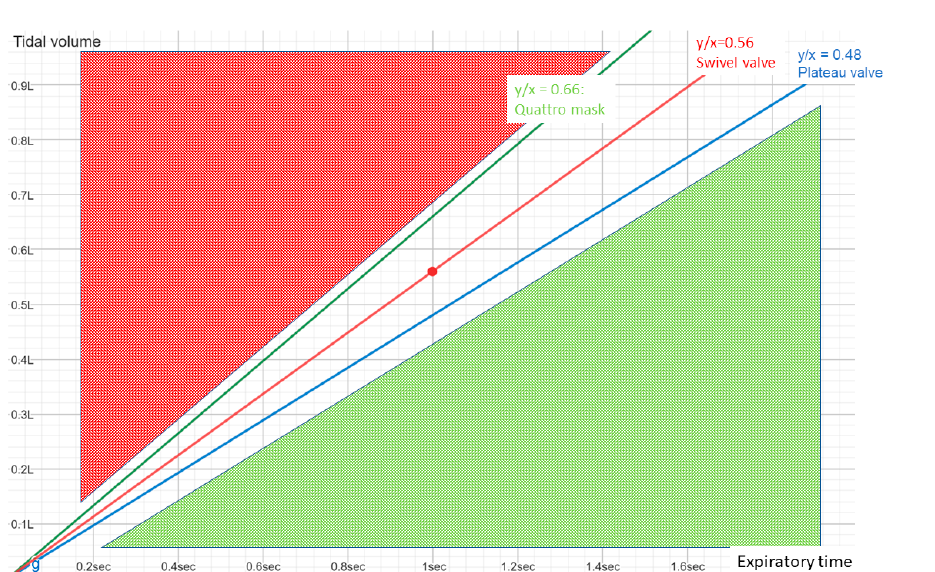
Figure 6. Estimated likelihood of rebreathing of three different types of intentional leakage. The slope for each mask corresponds to the amount of intentional leakage at PEEP = 4 cm H 2 O (upper panel). For any further increase in PEEP, an increase in the slope would be expected (lower panel, PEEP = 8). Red zone represents the high risk for rebreathing, whereas green zone represents the “safe” zone which increases with higher PEEP.